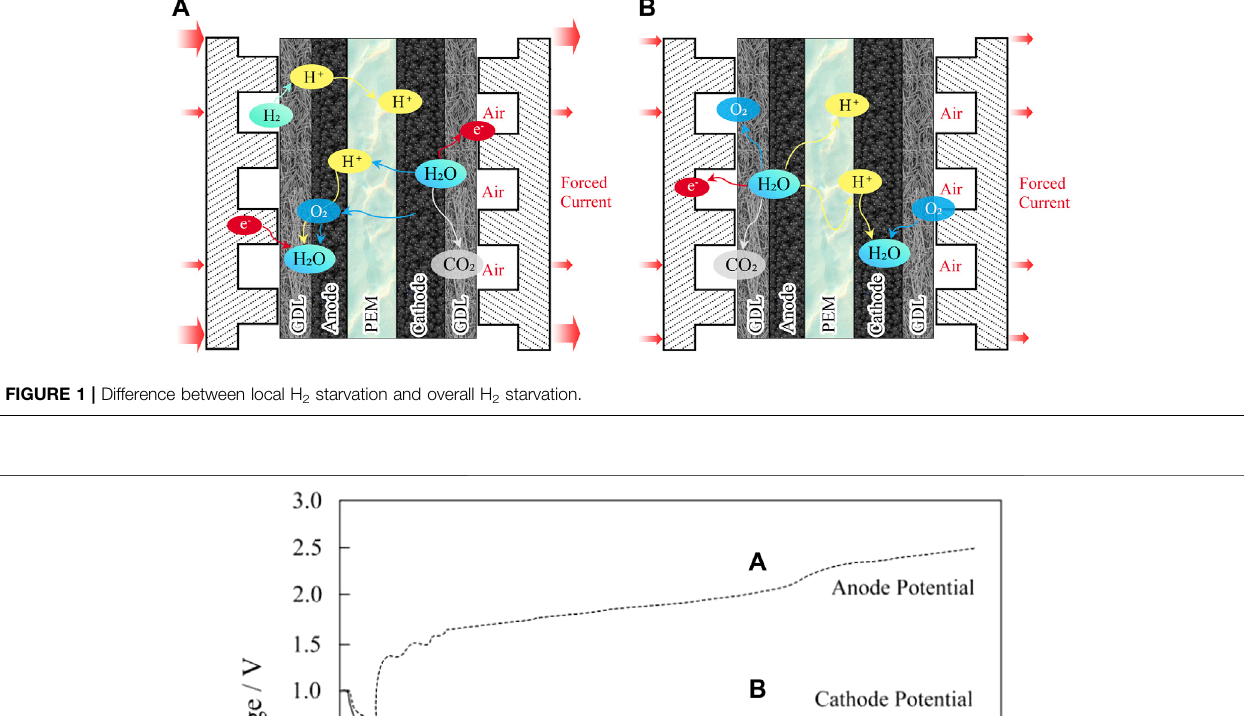
Frontiers in Energy Research |